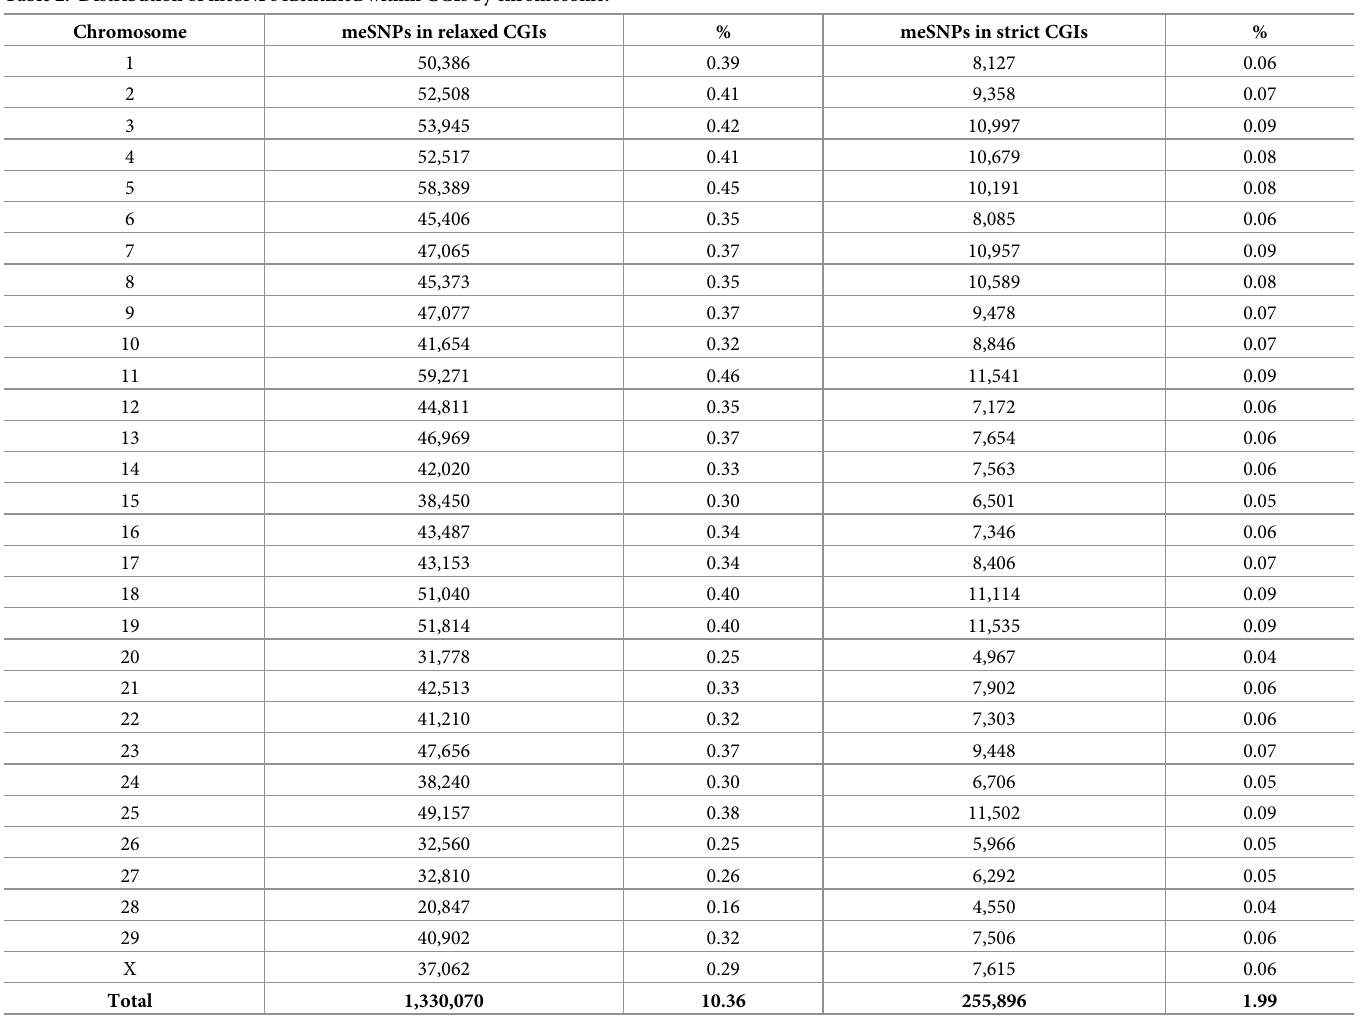
Table 2. Distribution of meSNPs identified within CGIs by